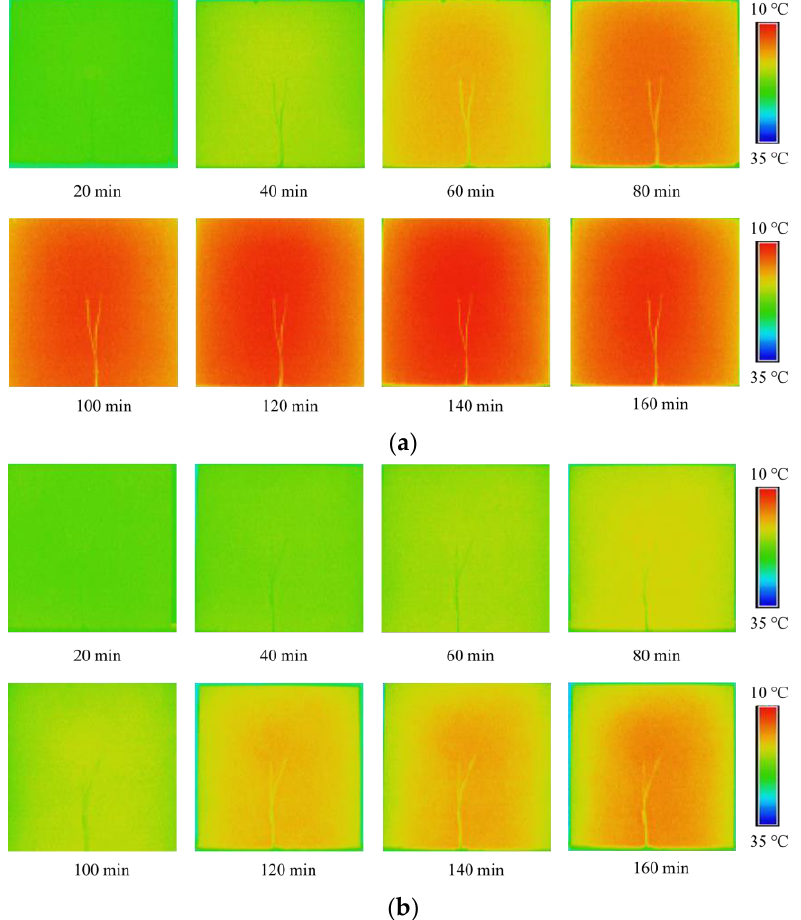
Figure 14. Temperature distribution of two kinds of aggregate concrete slabs. ( a ) Basalt aggregate concrete slab. ( b ) Phase change aggregate concrete slab.